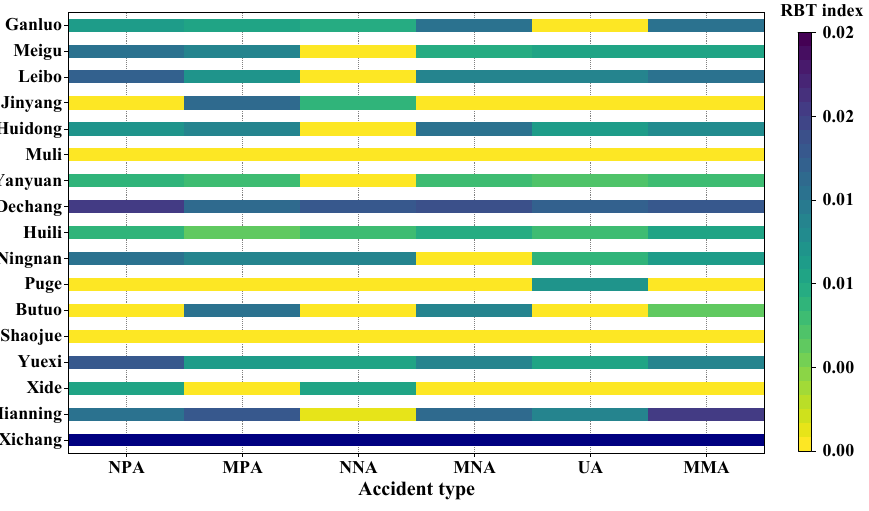
Figure 5. A summary of the RBT